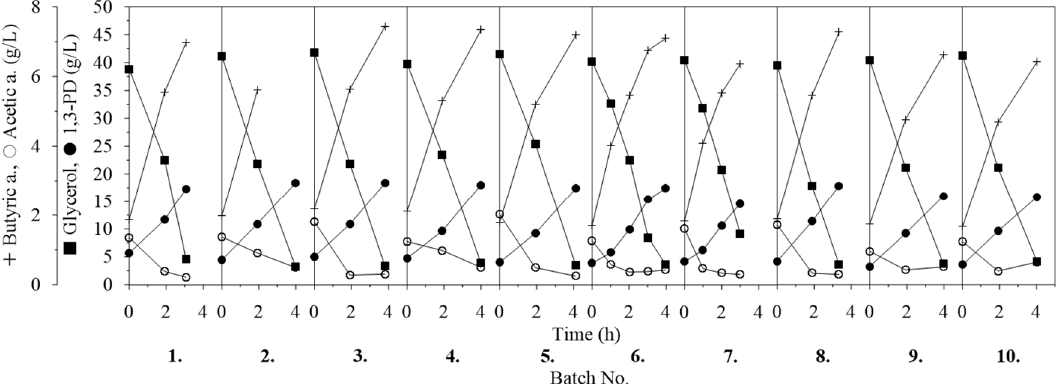
Figure 6. First 10 repeated batch fermentations with immobilized cells and crude glycerol derived from RO, at an initial concentration of 40.0 ± 1.2 g/L.